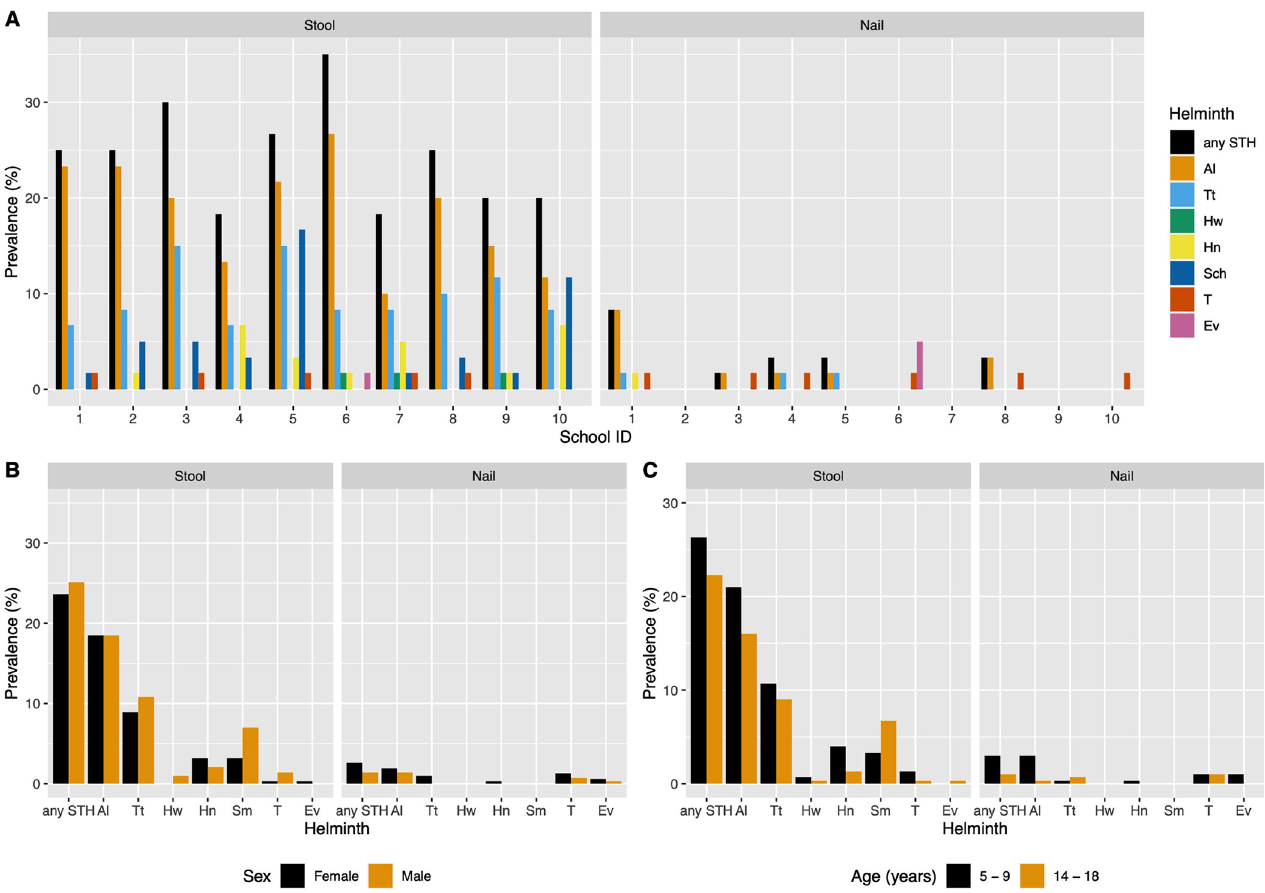
Fig 1. The prevalence of helminth eggs in stool and under finger nails across 600 schoolchildren. The bar plots represent the prevalence of helminth eggs in stool and under finger nails across 10 school ( Panel A ), 2 sexes ( Panel B ) and 2 age groups ( Panel C ). Any STH : any soil-transmitted helminth, Al : Ascaris lumbricoides , Tt : Trichuris trichiura , Hw : hookworm, Hn : Hymenolepis nana , Sch : Schistosoma mansoni , T : Taenia spp., Ev : Enterobius vermicularis